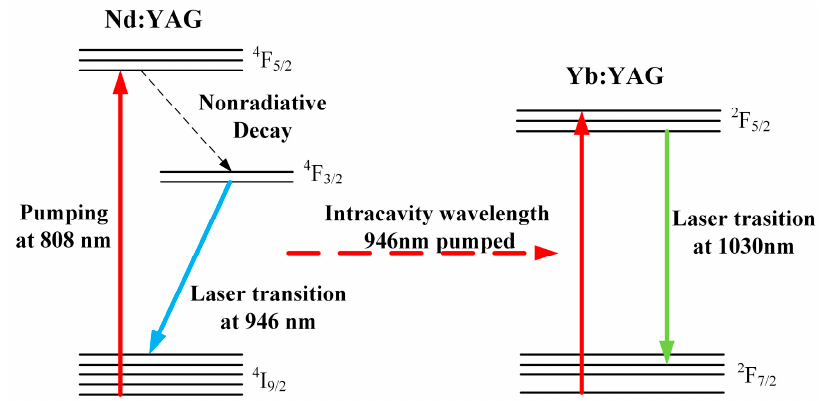
Figure 1. The energy level schematic of the intracavity cascading pumped method.